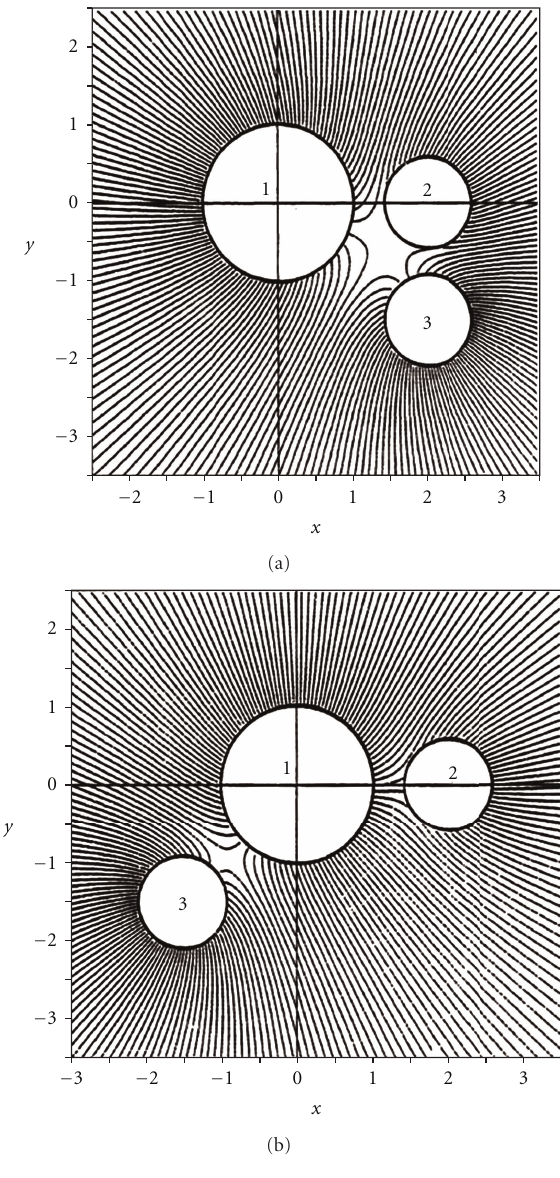
Figure 8: Model results for flow-field streamlines for three fires in close proximity (from [98]).